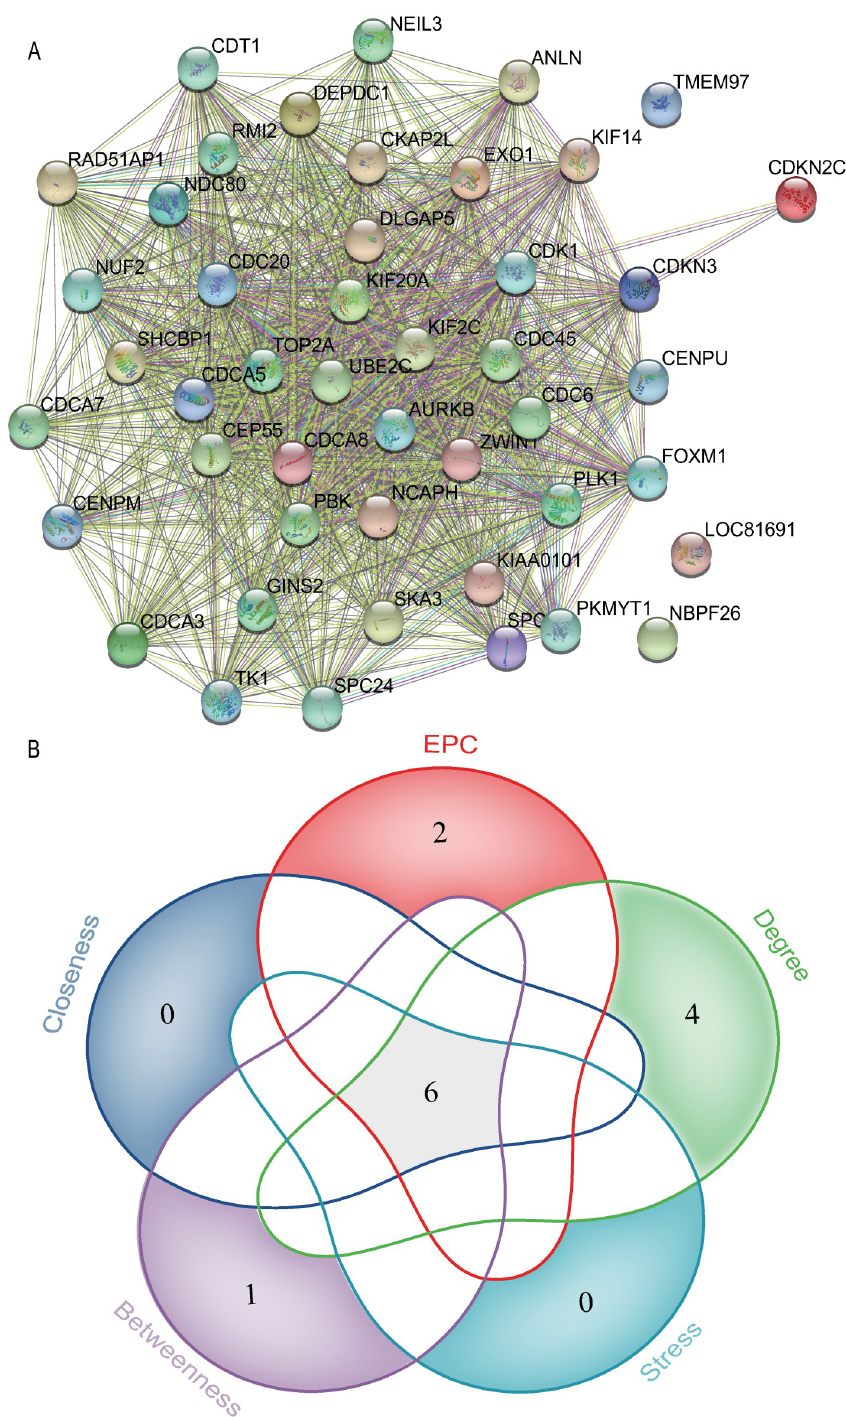
Fig 6. The number of critical genes were shown by using the cytoHubba plugin of cytoscape and the Venn diagram. EPC, Edge Percolated Component.